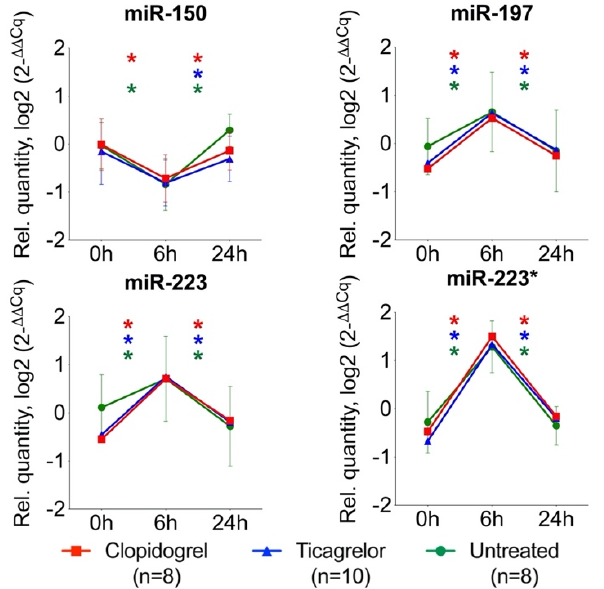
Figure 3. Effect of antiplatelet therapy on miRNA levels in endotoxemia. Endotoxin administration in volunteers markedly reduced levels of leukocyte-enriched miR-150 at 6 hours after endotoxin administration (6 h), while platelet-enriched miR-197, miR-223 and miR-223* showed an increase. Neither of these effects of endotoxin were altered by treatment with clopidogrel (red) or ticagrelor (blue), compared to the untreated group (green). After 24h, miRNAs returned to baseline levels (0 h). Data is represented as the geometrical mean with the 95% confidence interval. Statistical testing was performed using Wilcoxon’s signed rank test for consecutive timepoints within each treatment group. p-values were adjusted for multiple testing by the Benjamini–Hochberg method. * denotes False Discovery Rate-adjusted p-value <0.05.